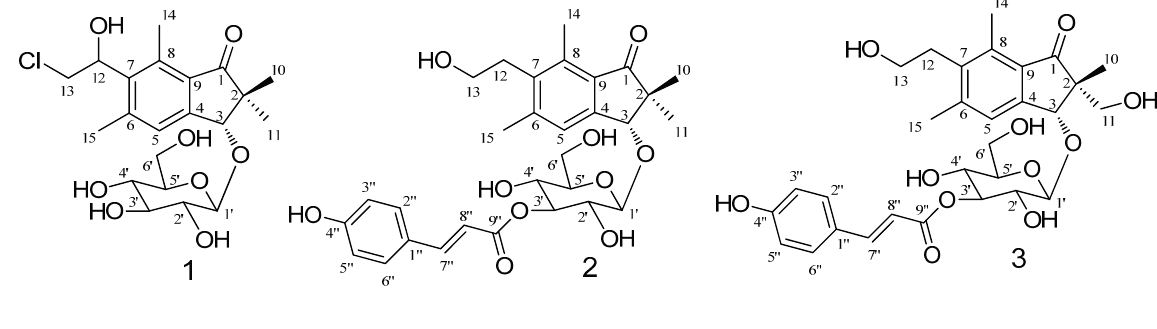
Figure 1. Structures of Compounds 1 – 3